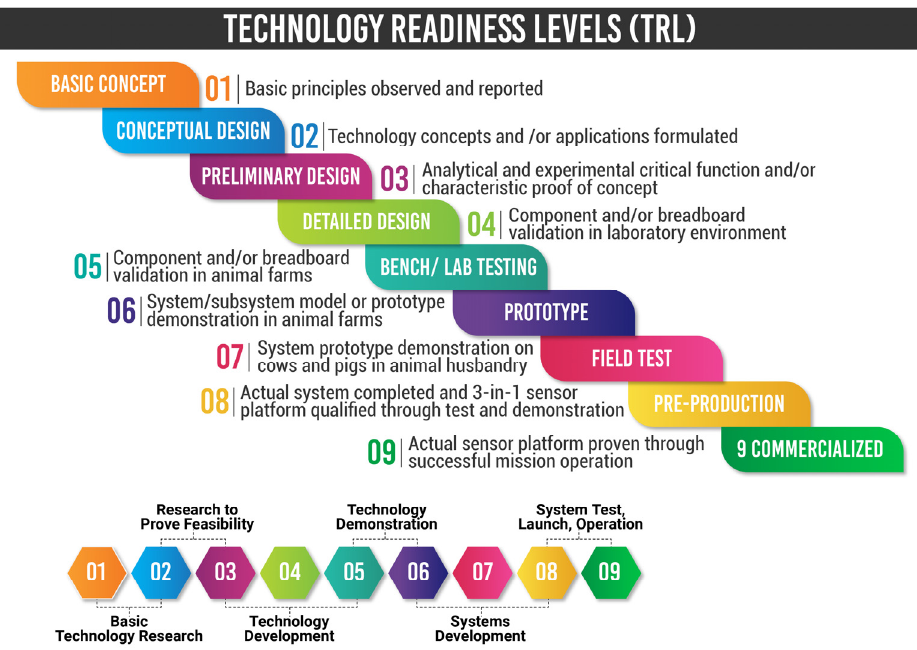
Figure 1. Overview of Technology Readiness Level (TRLs) for the SOLARIA project.